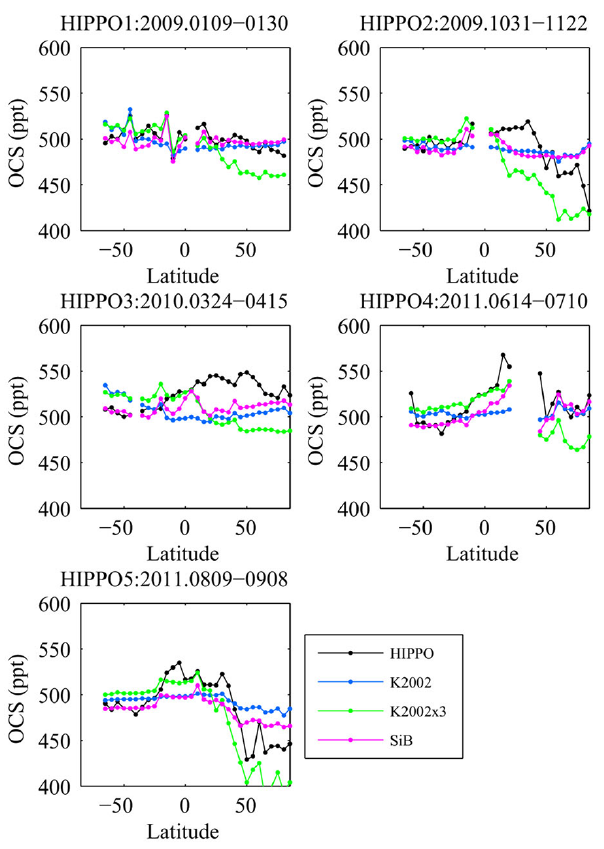
Figure 3. Comparison of HIPPO-OCS measurements and model simulations. The five campaigns are compared separately to show latitudinal gradient in different seasons. To minimize the influence of the stratosphere, only the measurements lower than 9km are used. The model outputs are selected at the nearest measurement lo- cation and time. The measurements and model output are averaged in 5 ◦ bins. The HIPPO data are shown by black dots. The model simulations are in the same colors as those shown in Fig. 2.